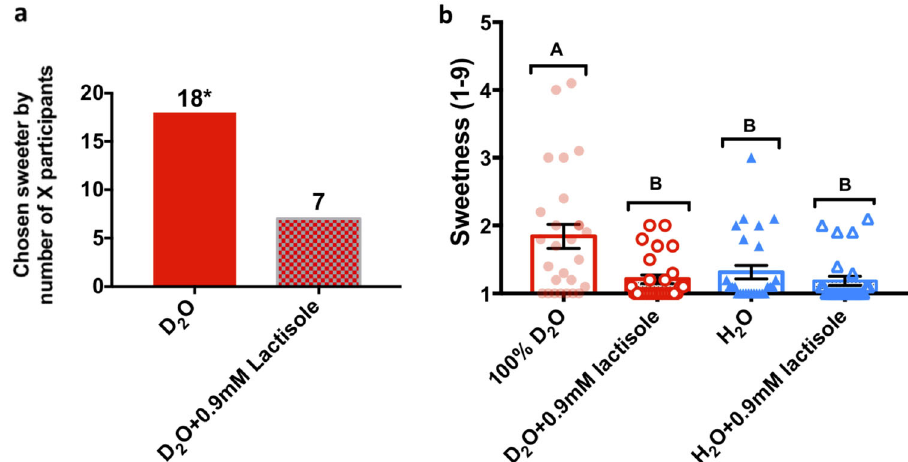
Fig. 4 Lactisole reduces sweetness of D 2 O. a 2AFC test. Pure D 2 O was chosen to be sweeter ( p < 0.05) than the sample with lactisole by 18 participants ( n = 25; 11 males). b Effect of 0.9 mM lactisole on sweetness intensity using the 9-point scale. Data are presented as the mean ± SEM. The y axis shows the response for sweetness on a 9-point scale, while the x axis is labeled with different water samples. Statistical analysis was performed using ANOVA with a Tukey Kramer test ( n = 27; 9 males); treatments not connected by the same letters are signi fi cantly different ( p < 0.05). Scale for sweetness is labeled as 1 = no sensation, 3 = slight, 5 = moderate, 7 = very much, and 9 = extreme sensation.